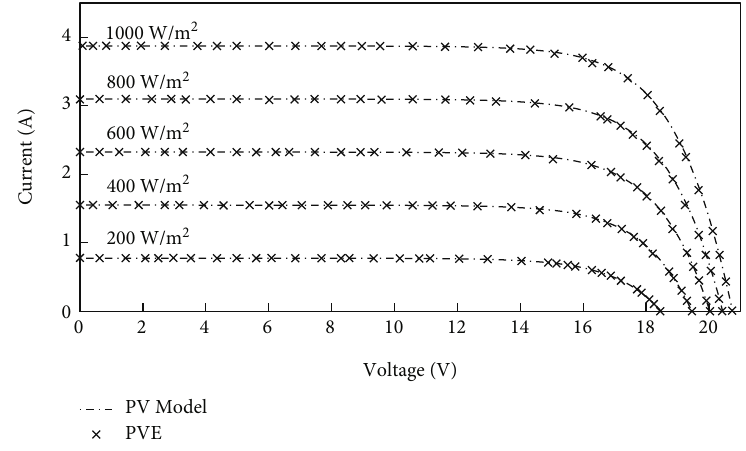
− I Þ points plotted on the PV model current-voltage characteristics. pve pve